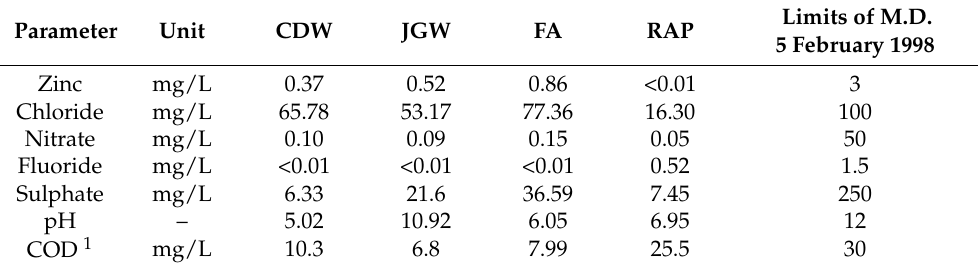
Table 2. Metals and organics concentrations above the quantification limits and pH of the eluate of the leaching test for the analyzed waste materials and limits set by M.D. issued on 5 February